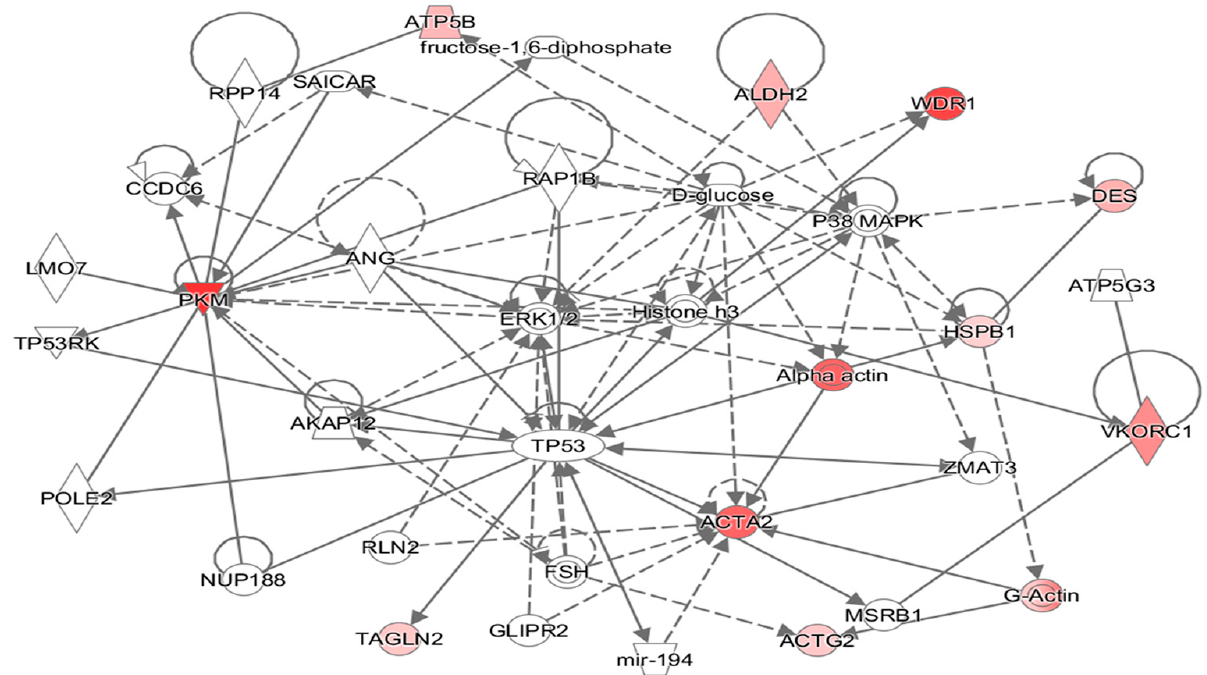
Figure 4. Putative biochemical networks affected by thermal exposure, as revealed by Ingenuity Pathway Analysis (IPA). Differentially abundant proteins showing a +/ − 2-fold change or greater ( p < 0.05) were selected and entered into the IPA Software to identify potential interactions. Solid arrows represent known physical interactions, while dotted arrows represent indirect interactions. Red shapes indicate proteins in this network that were identified by 2D-GE and mass spectrometric analysis. The proteins were mapped to their corresponding human homologues in the Ingenuity Pathways Knowledge Base. The homologues used in this study are as follows: ATP5B, ATP synthase subunit β mitochondrial; HSPB1, Hsp27; ACTA2, actin aortic smooth muscle; ACTG2, actin γ ; TA- GLN, transgelin; WDR1, WD repeat-containing protein; ALDH2, aldehyde dehydrogenase; PKM, pyruvate kinase; VKROC1, vitamin K epoxide reductase complex, subunit 1-like 1; DES, desmin.